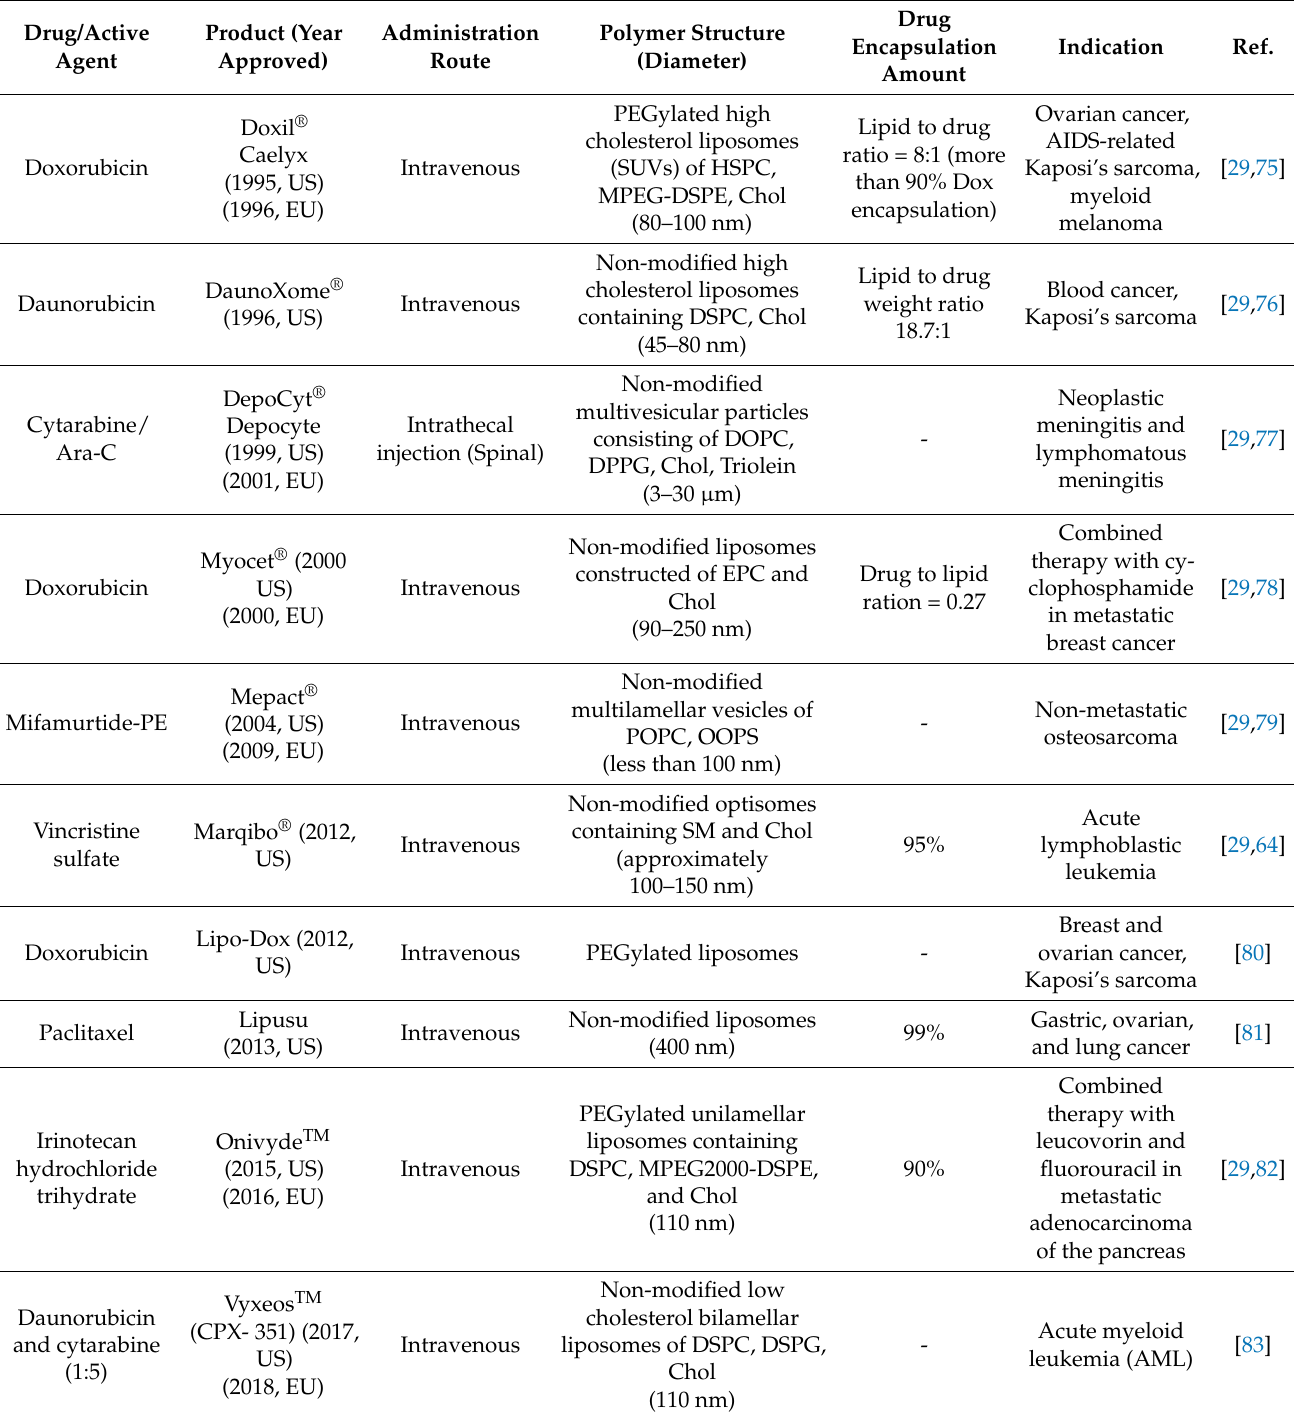
Table 1. Summary of the FDA/EMA-approved liposomal